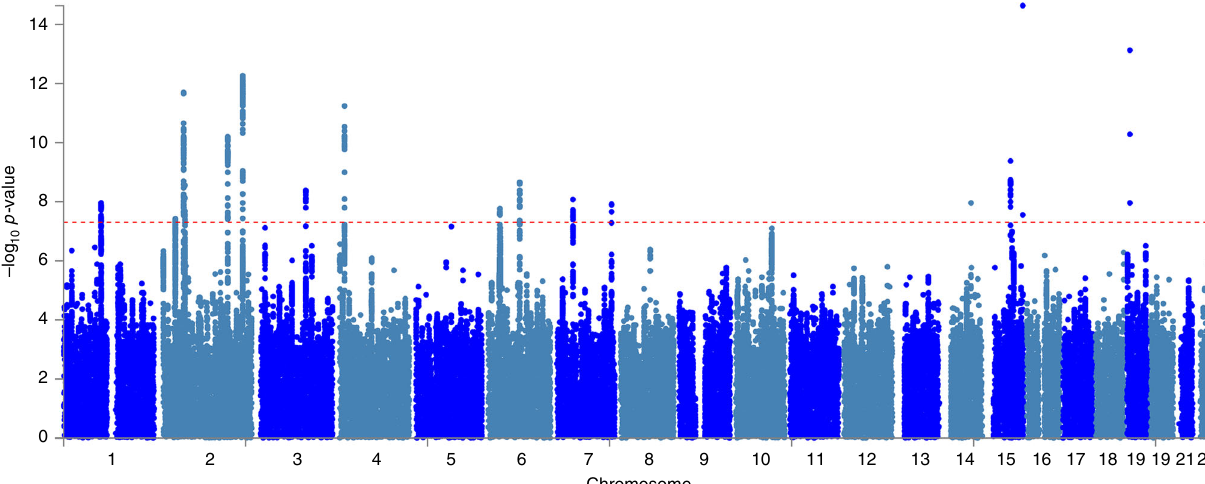
Fig. 1 SNP associations with carpal tunnel syndrome. Manhattan plot showing -log 10 p values for SNP associations, produced in FUMA 25 . The horizontal red line represents p = 5 × 10 -8 . SNP, single-nucleotide